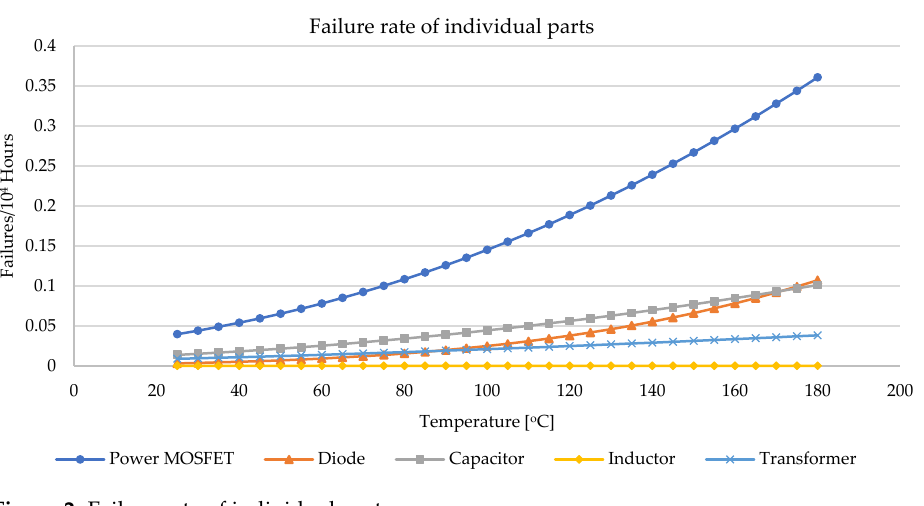
Figure 2. Failure rate of individual parts.